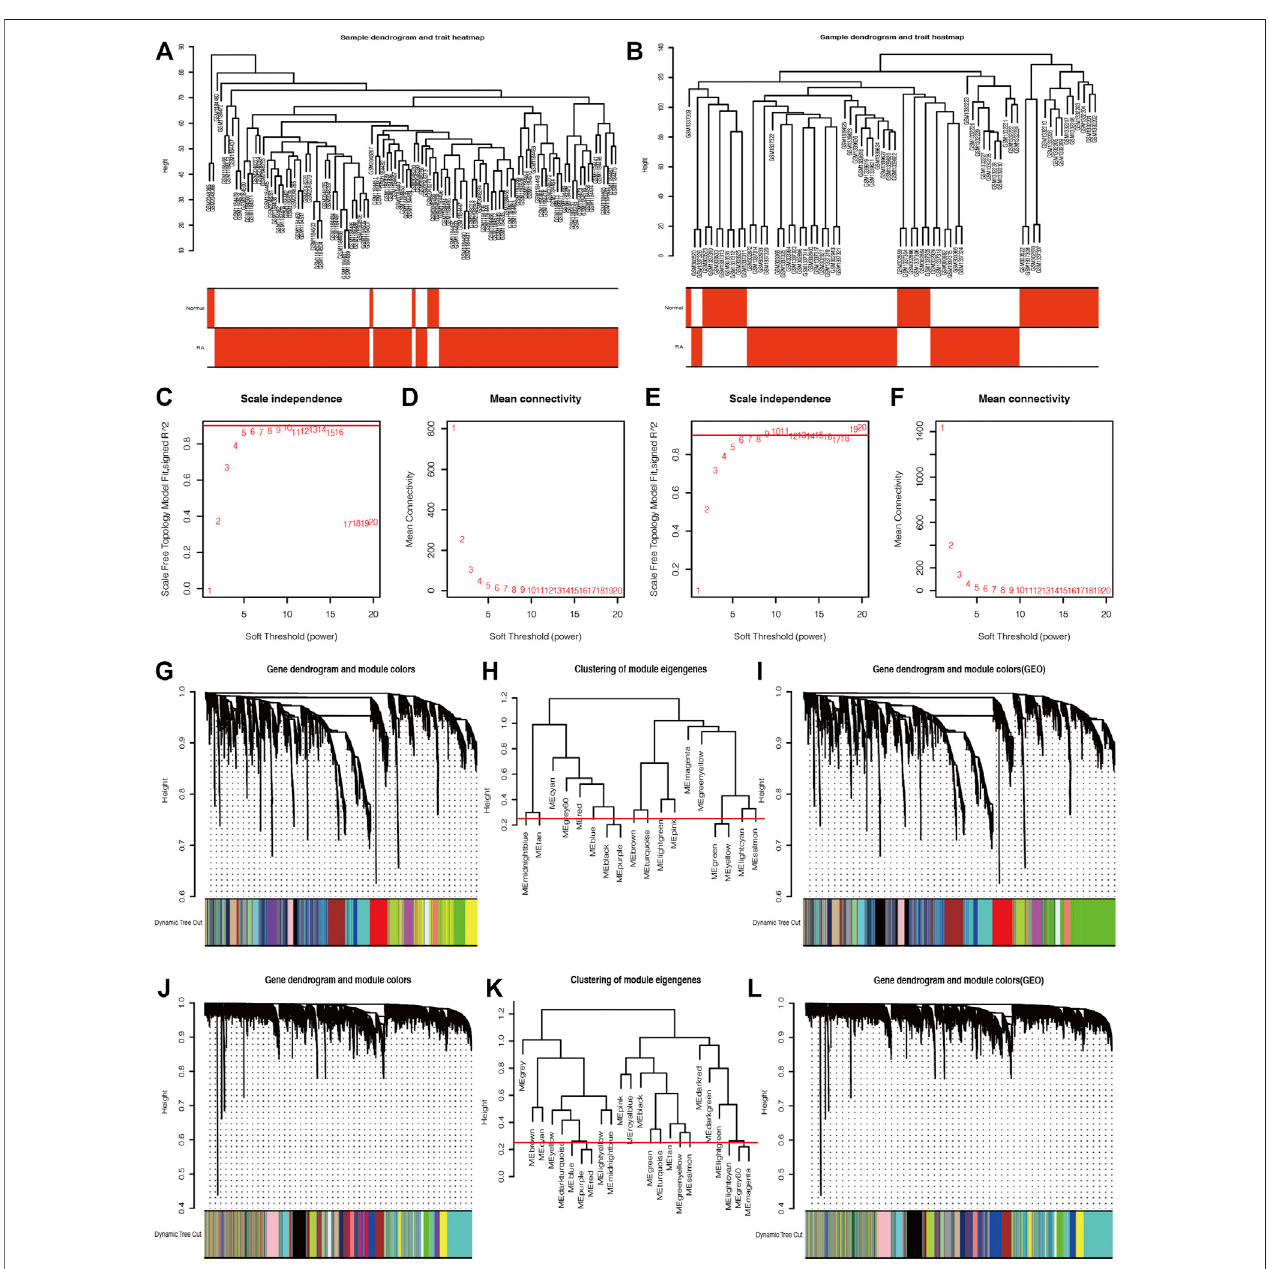
FIGURE 4 | The weighted gene co-expression network analysis (WGCNA) algorithm was applied to explore the most correlated gene modules. The sample dendrogram and trait heatmaps of the GPL96 database (A) and GPL570 database (B) . The optimum soft threshold power was determined based on the scale independence plot and mean connectivity plot in the GPL570 (C and D) and GPL96 databases (E and F) . The gene clustering dendrogram was constructed based on dissimilarity, and the related gene modules were merged with the dynamic tree cut method by hierarchical clustering in the GPL570 (G – I) and GPL96 databases (J – L)